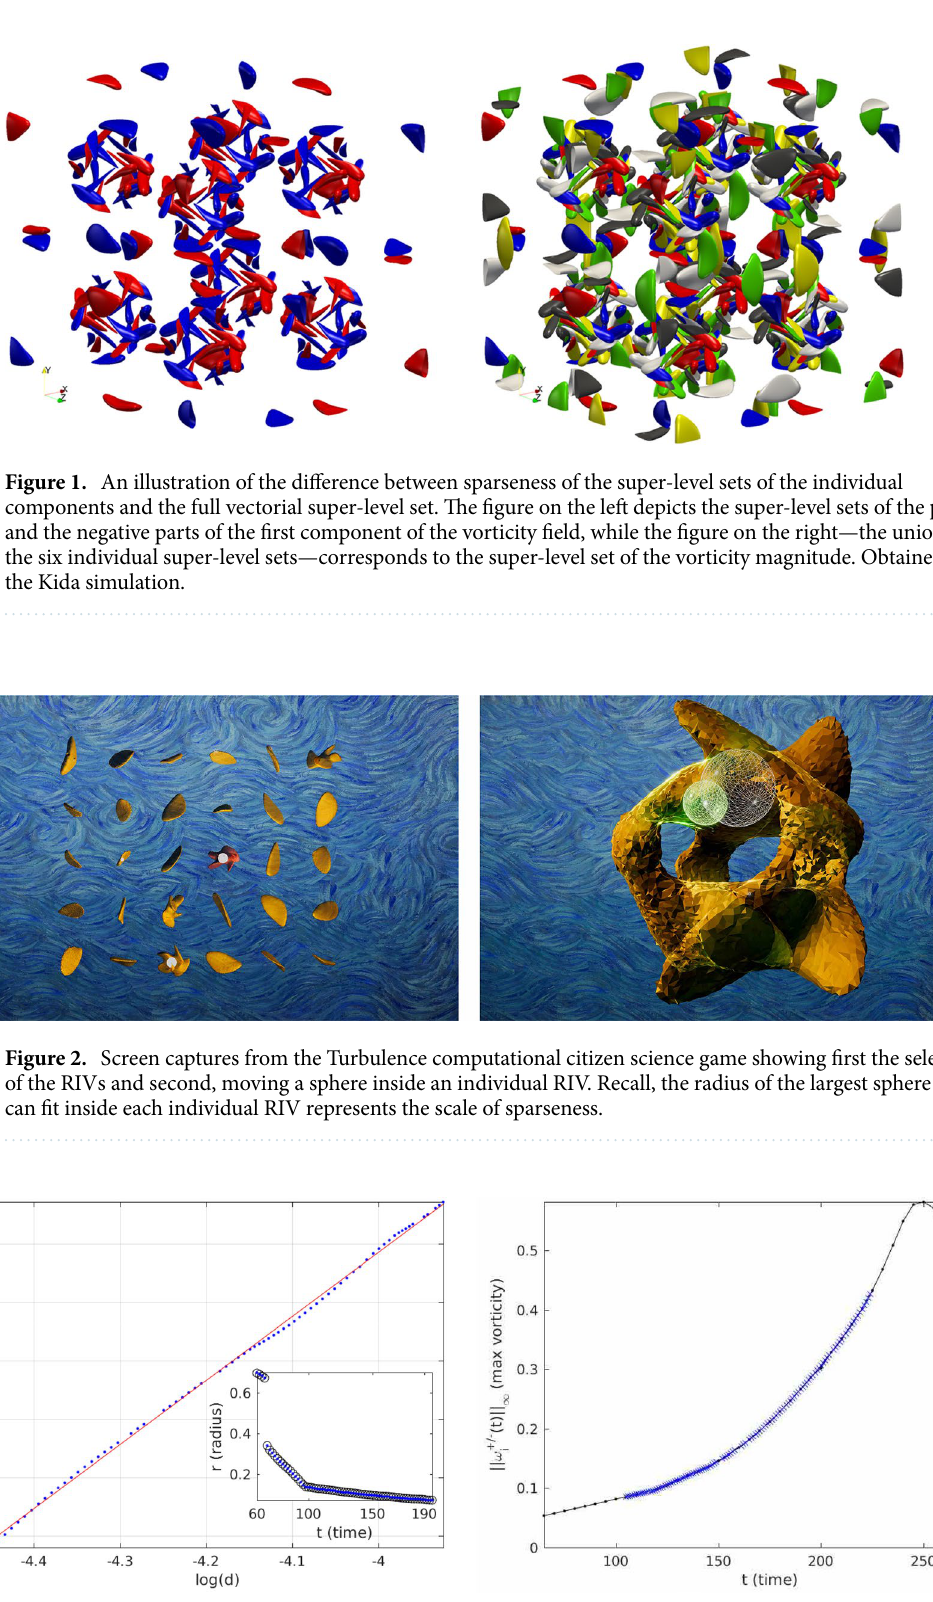
Figure 3. The figure on the left is a Log–log plot of the scale of three dimensional sparseness (of the vorticity components) vs. the diffusion scale. The summary of the regression is as follows: fit = [ 1.098 ± 0.009 ] log d + [ 2.17 ± 0.04 ] . The inset compares the algorithmically calculated r max [the small dots] to the r max [the small circles] found by citizen scientists. The figure on the right is the time-evolution of the vorticity magnitude. The highlighted region indicates where the data was sourced